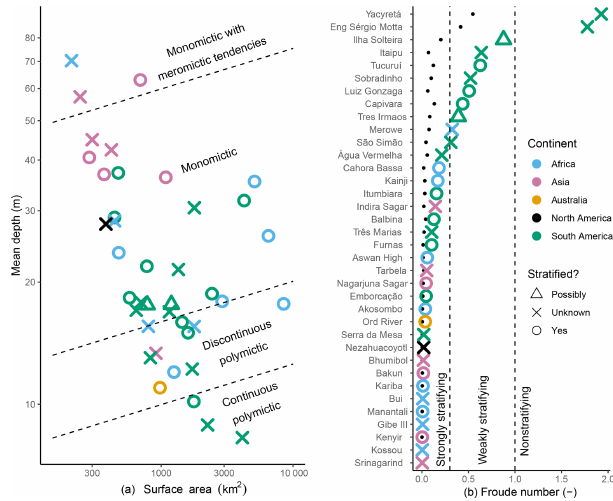
Figure 4. Reservoir morphometry and stratification behavior. (a) Relationships between area and depth for 40 of the 54 world’s most-voluminous reservoirs located below ± 35 ◦ latitude. Data are from the International Commission on Large Dams (https://www. icold-cigb.net/, last access: 1 August 2018) (we excluded 14 reser- voirs because of missing surface area data). Stratification behavior classification is synthesized from literature: circle symbols indicate that the reservoir has an extended, predictable season of stratifica- tion and/or mixes deeply no more than once per year; triangle sym- bols refer to two Brazilian reservoirs that authorities suggest are likely to be polymictic, but for which no direct observations ex- ist (see Tundisi, 1990; Padisak, 2000); for reservoirs indicated by cross symbols, no published information on stratification behavior appears in literature searches. Dashed lines and classification la- bels are approximations proposed by Lewis (2000). (b) Reservoirs sorted by densimetric Froude number, which is a function of reser- voir depth, length, volume and discharge (Parker et al., 1975). The vertical dashed lines at Fr = 1 and Fr = 0 . 3 indicate the expected boundaries between strongly, weakly and nonstratifying reservoirs (Orlob, 1983). Small dots represent Froude numbers if maximum depth (height of dam wall) is used instead of mean depth as sug- gested by Ledec and Quintero, 2003. Discharge data is from the Global Runoff Data Centre (https://www.bafg.de/GRDC, last ac- cess: 1 August 2018); five dams were excluded because of missing discharge